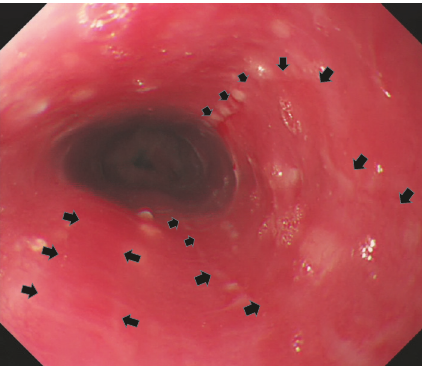
Figure 2: Second endoscopy view (postthermal injury day 5). Alternating geographic, longitudinal, geographic, whitish pseu- domembranous (arrow) and inflamed, erythematous mucosa.